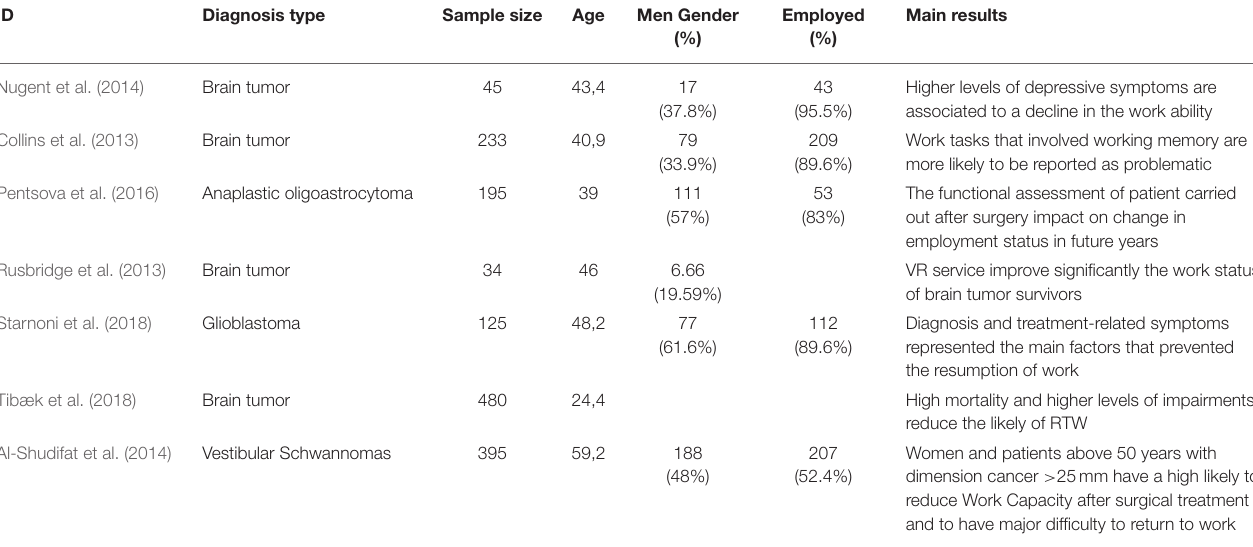
TABLE 1 | Main characteristics and main outcomes of the included